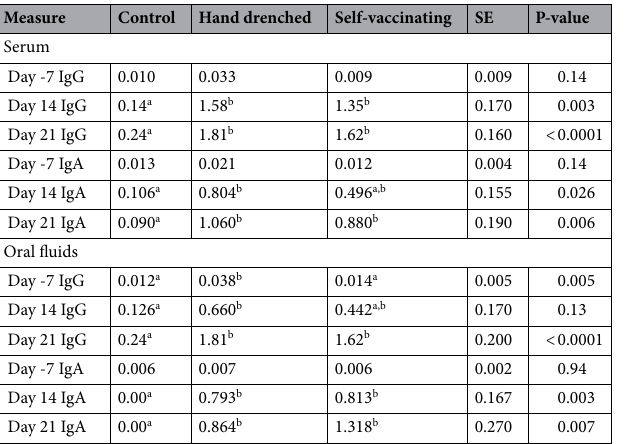
Table 1. Serum and oral fluids relative concentrations of antibodies (S:P) to IgG and IgA for pigs in the three treatment groups. N = 12 pigs per treatment mean unless there was insufficient quantity for testing. Least squares (LS) means within a row with a different superscript ( a,b,c ) differ, P < 0.05. For LS means on days 14 and 21, the time zero values were used as a covariate to equalize time zero values across treatments.